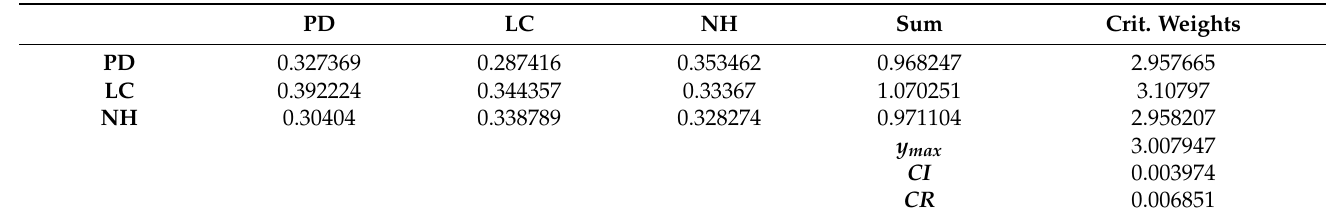
Table 7. Computation of CR and CI of exposure parameters for consistency of AHP.